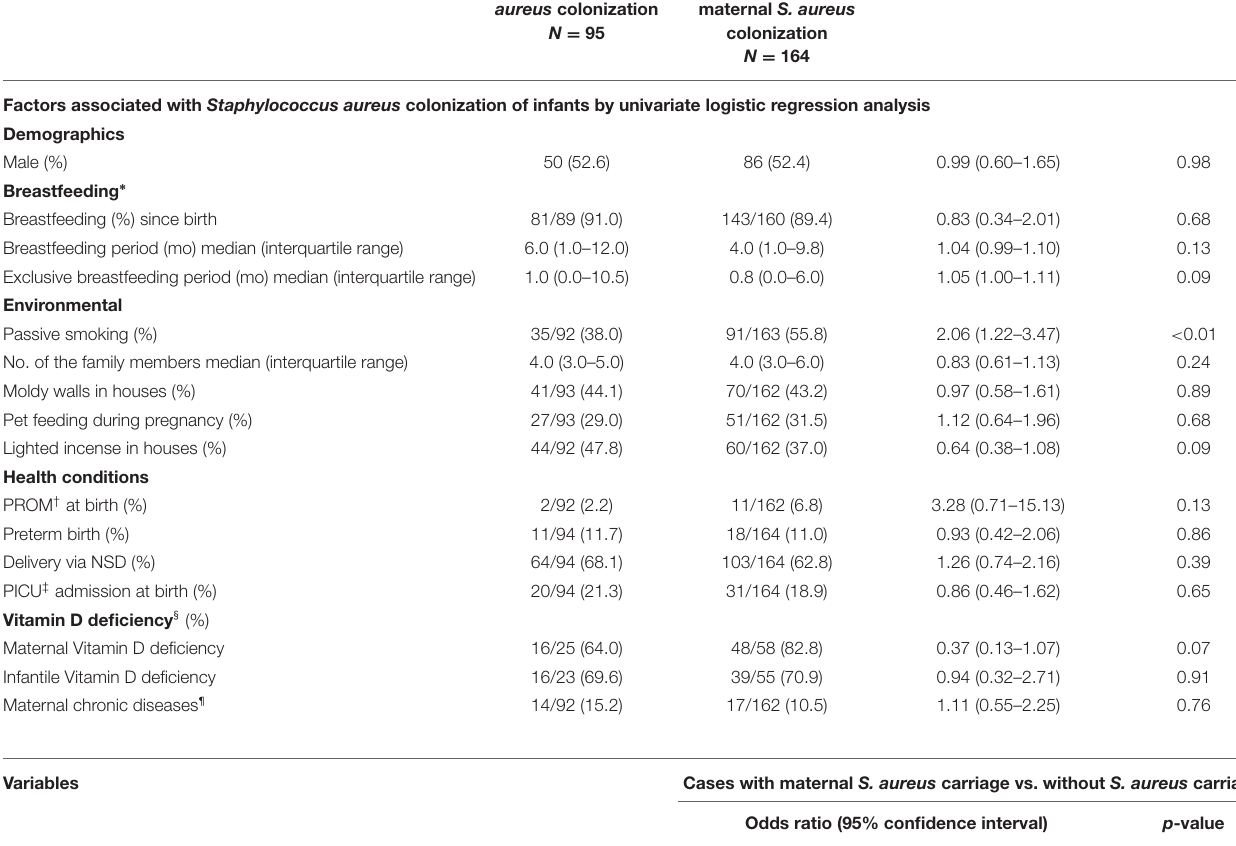
p -value (95% confidence interval) Cases without Cases with maternal S. aureus colonization maternal S. aureus N = 95 colonization N =